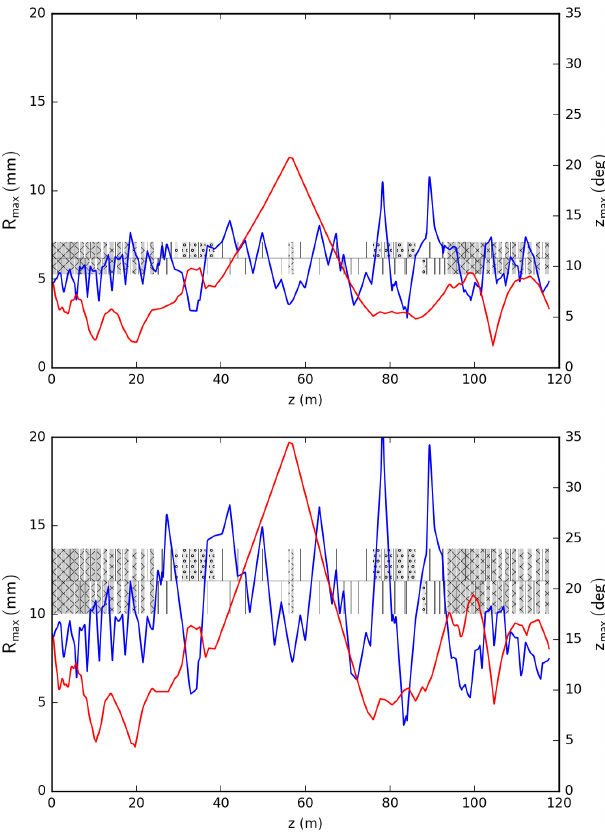
FIG. 20. rms beam statistics from the first-pass LINAC entrance to the second-pass LINAC exit for 40 mA bunch current and Gaussian initial distribution.